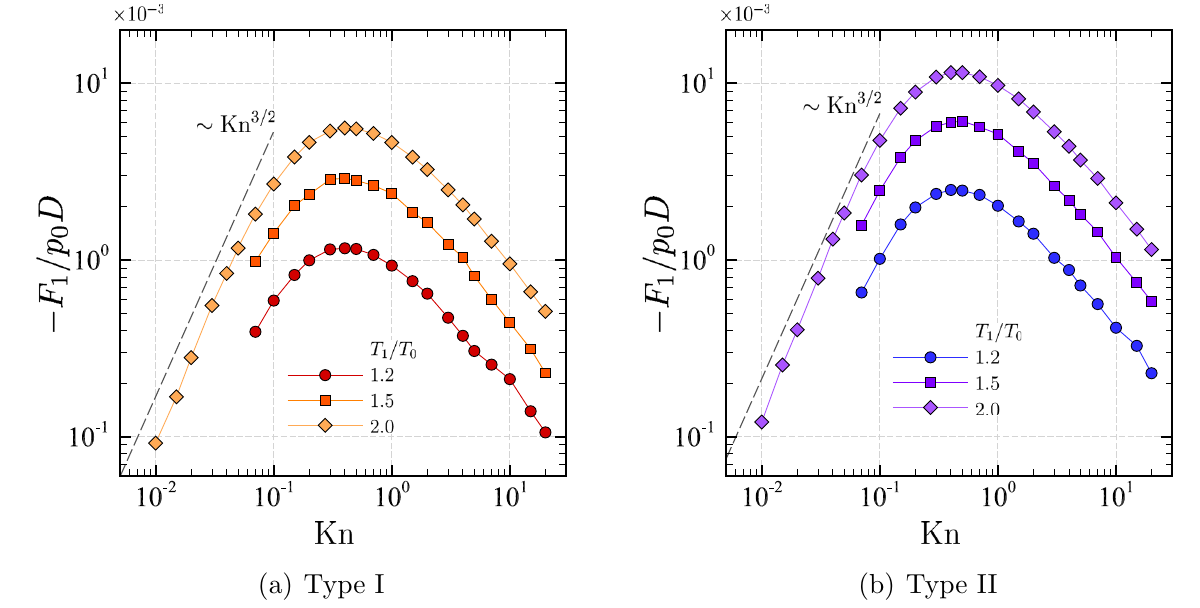
Figure 10. Semi-logarithmic plot of the force ( F 1 , 0, 0 ) acting on each of the U-shape bodies as a function of the Knudsen number Kn for T 1 / T 0 ( a ) Type I (square-U shape) and ( b ) Type II (round-U shape). See the caption of Fig. 9.